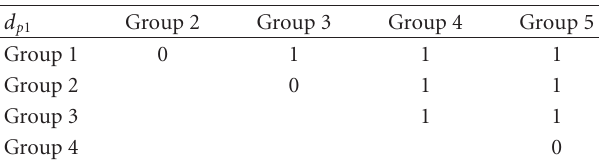
Table 4: Pairs of groups for d p 2 for which the escaped debris di ff er significantly from each